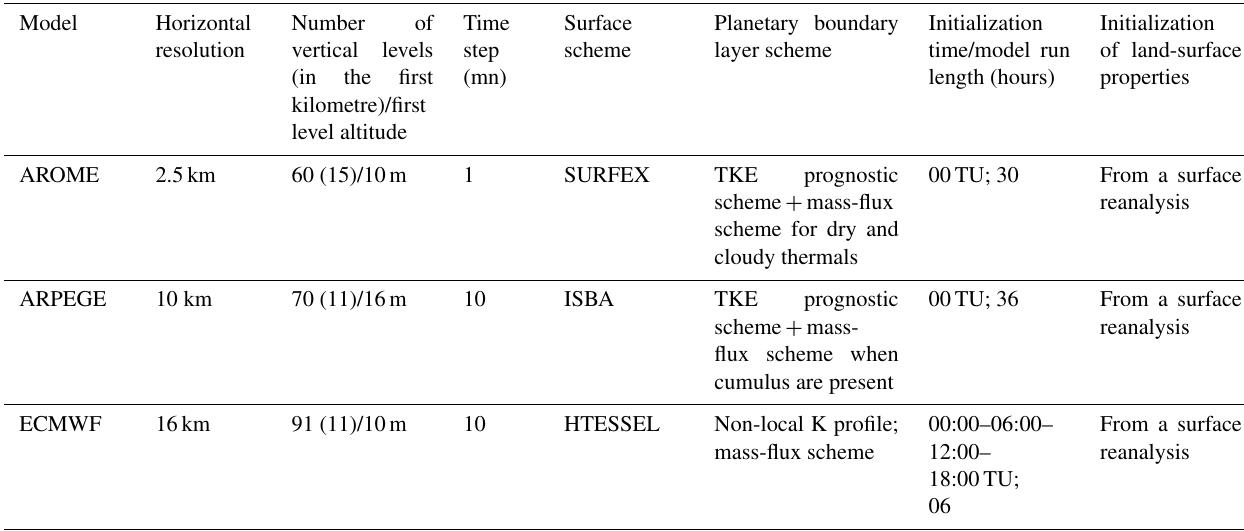
Table 2. Description of the three models.